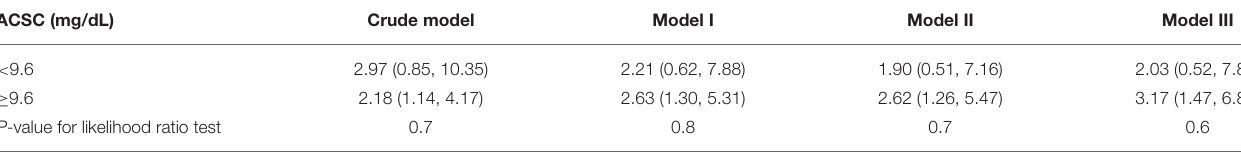
TABLE 4 | Two-piecewise linear regression analysis for ACSC and 30-day mortality.